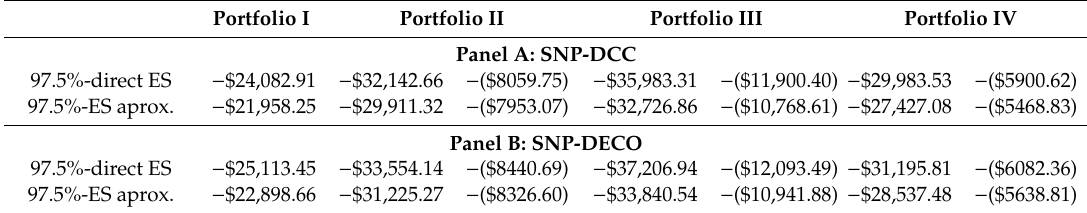
Table 8. Portfolio Incremental Expected Shortfall for the SNP-DCC and SNP-DECO